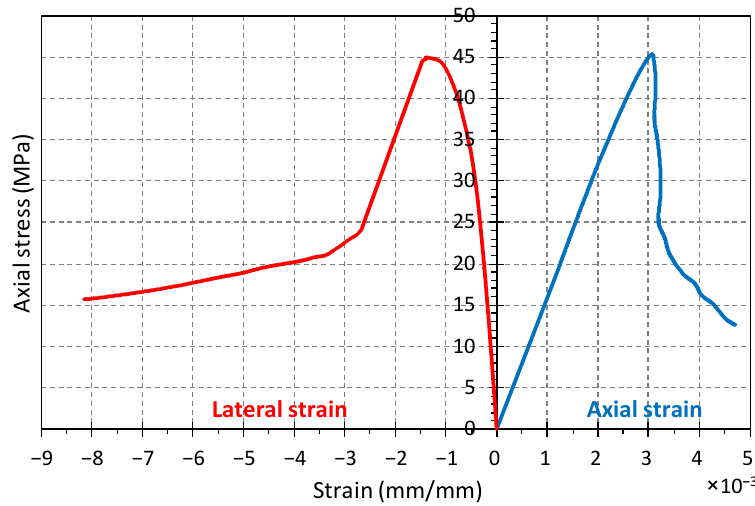
Figure 8. Cylinder’s compression stress vs. lateral and axial strain curves for fiber-reinforced concrete.